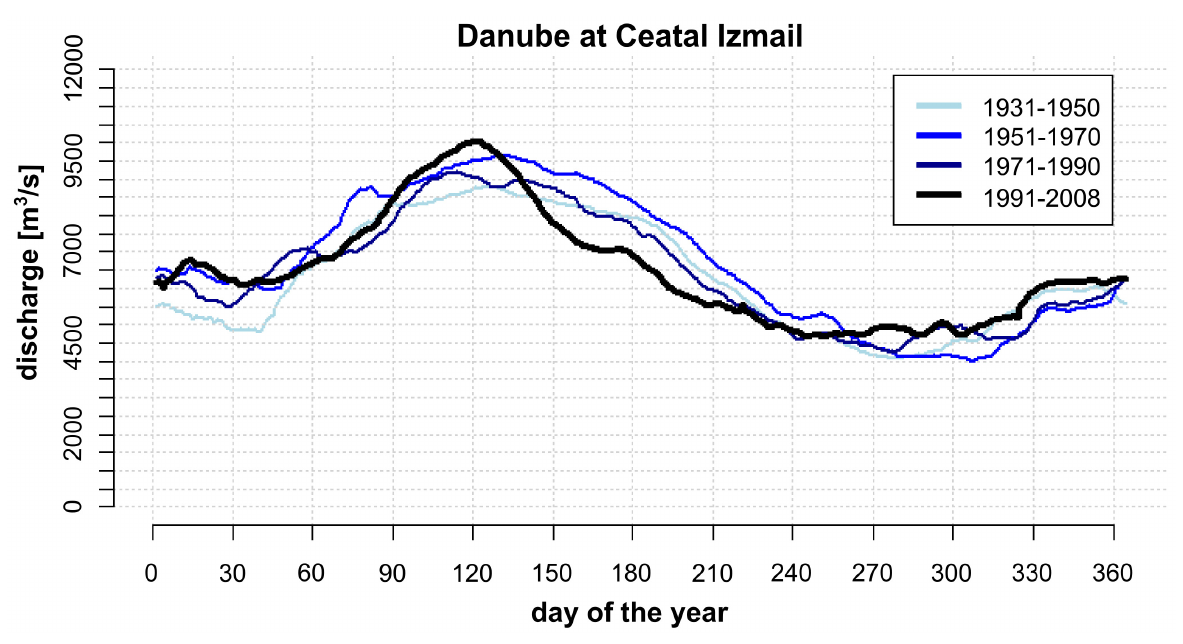
Figure 3. Historic changes in the long-term seasonal runoff of the Danube River at the entrance to the Danube delta (Ceatal Izmail